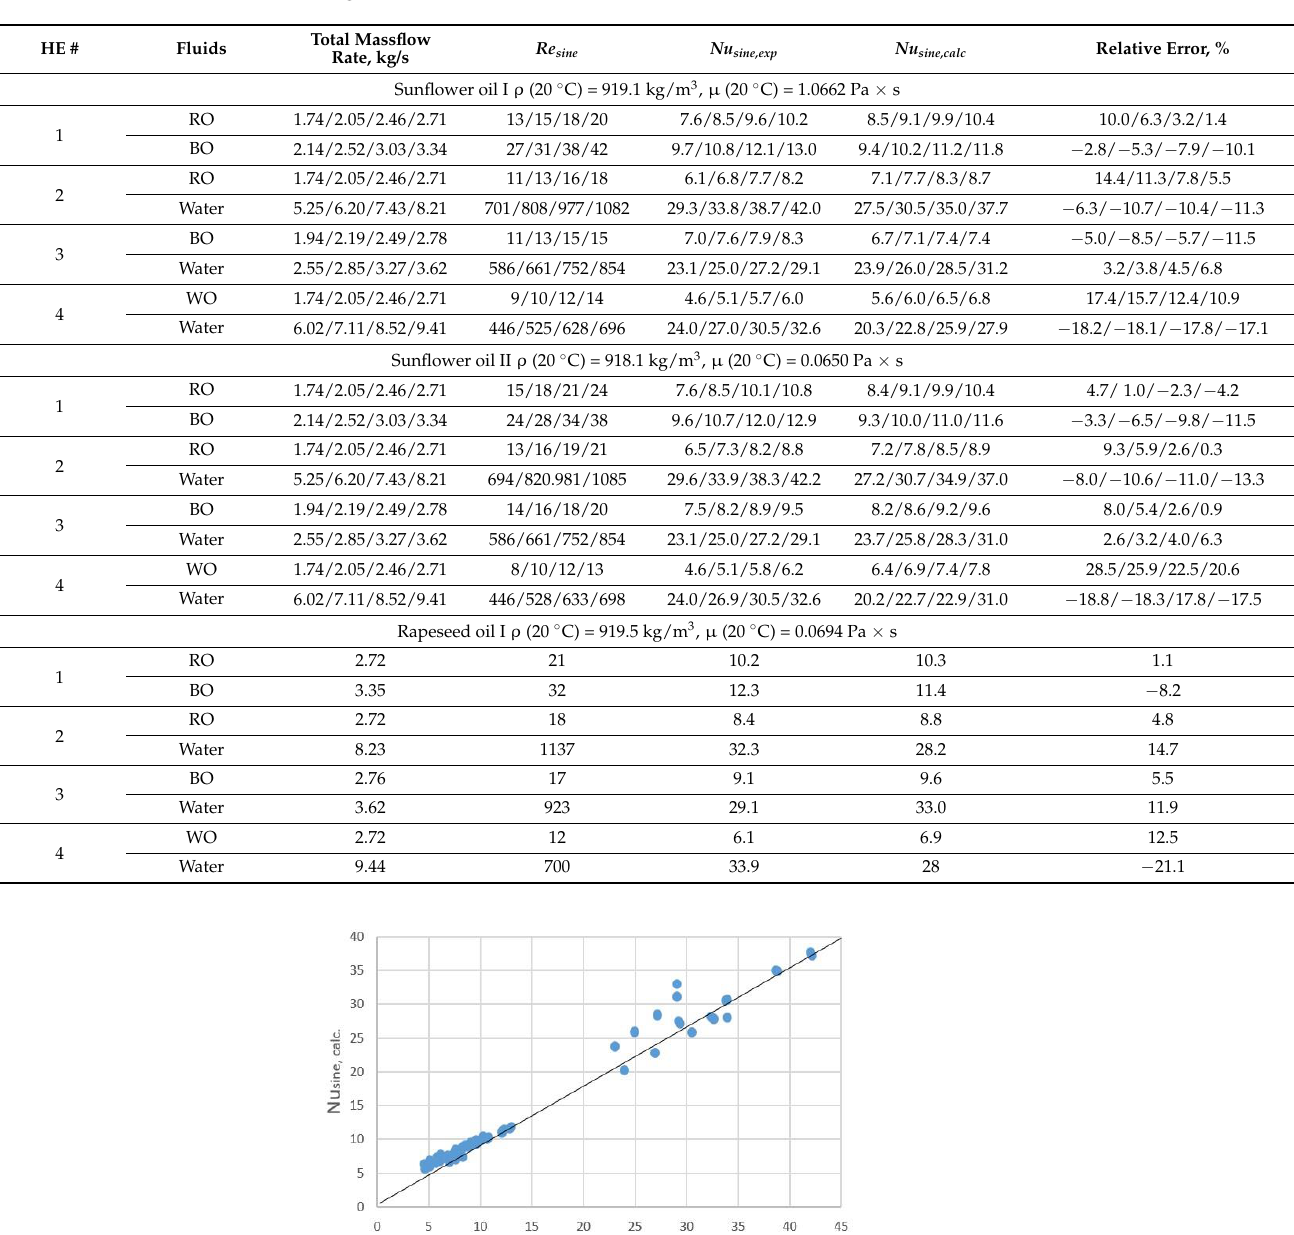
Table 7. Statistical data analysis for Re sine vs. Nu sine / Pr 1/3 ( μ / μ w ) 0.14 correlation. SUMMARY OUTPUT